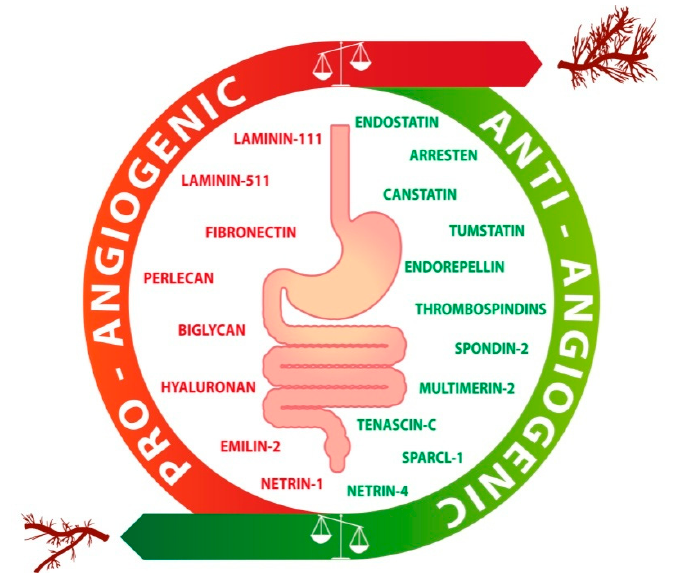
Figure 1. Schematic drawing of the angiogenic switch in gastrointestinal cancers. The angiogenic switch occurs upon an imbalance between pro-angiogenic (red) and anti-angiogenic (green) molecules. The scheme reports the major extracellular matrix molecules regulating angiogenesis in the context of GI tumors.